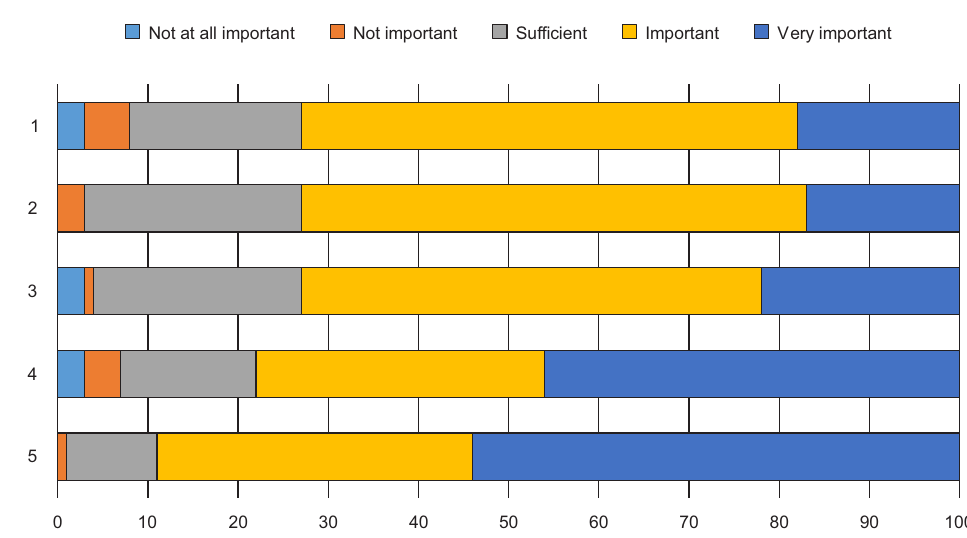
Fig. 9. Respondents assessment of factors that may increase their